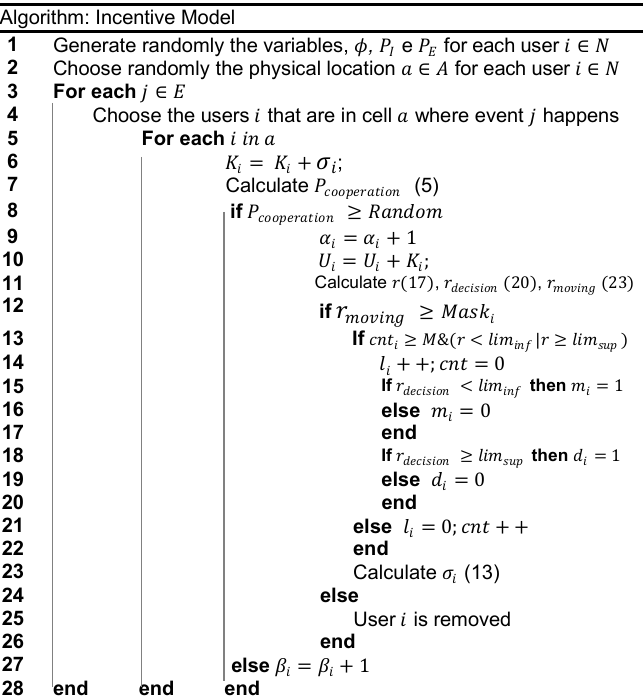
Figure 10. ( a ) Flowchart of the incentive mechanism in its first stage; ( b ) Flowchart of the incentive mechanism in its second stage.